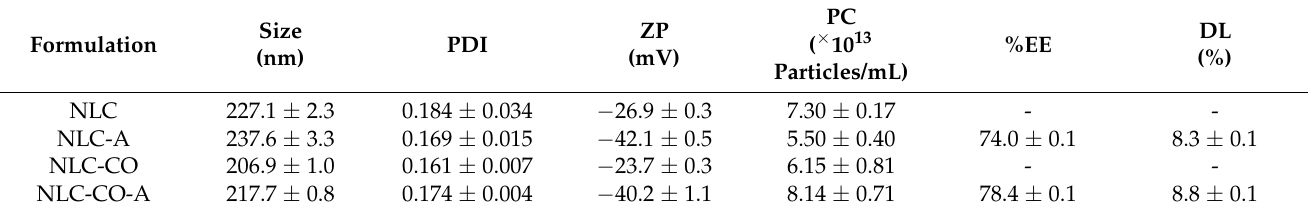
Table 2. Physicochemical properties of NLCs: particle size, polydispersity index (PDI), zeta potential (ZP), particle concentration (PC), ATC encapsulation efficiency (%EE), and drug loading (DL) capacity. Adapted from [8].